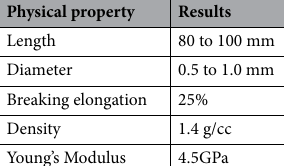
Table 2. Properties of CFs.